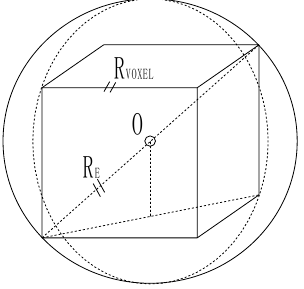
Figure 5. Inscribed cube inside the spheres represents the 3D extension of the valid area of HFD.